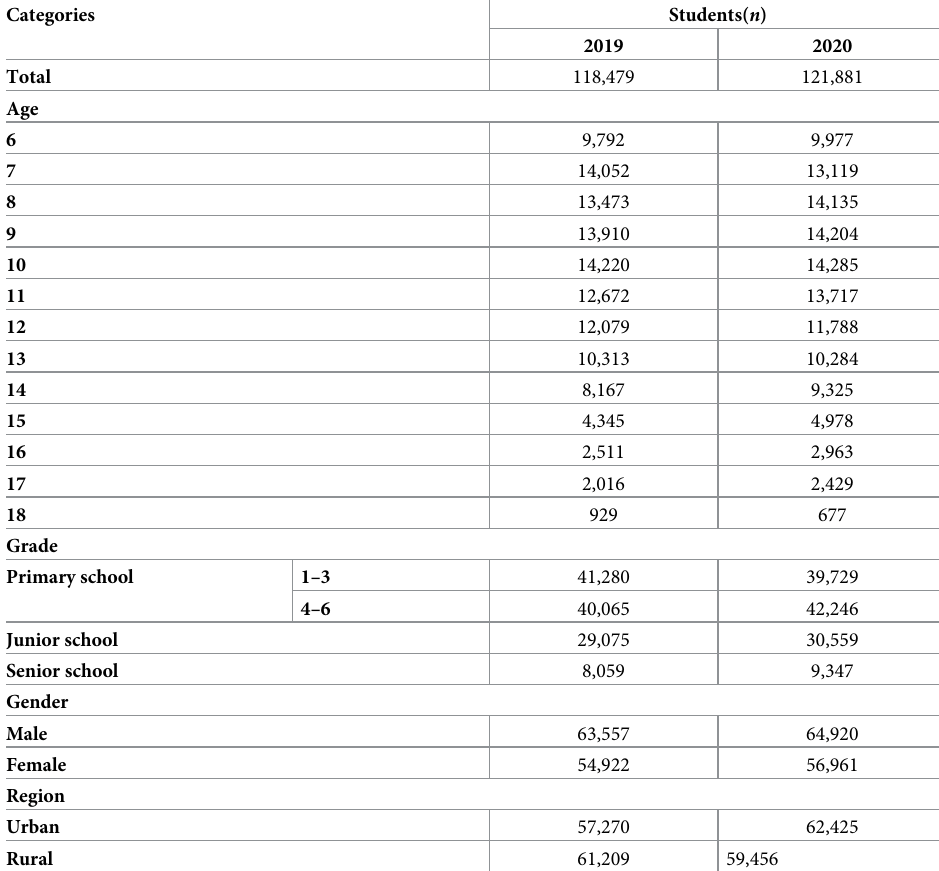
Table 1. The distribution of populations with different demographic